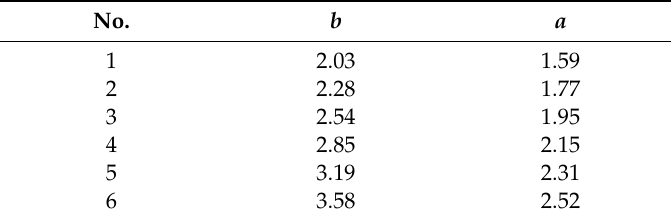
Table 5. Long axis and short axis of six trace lines in the first stage (Units: